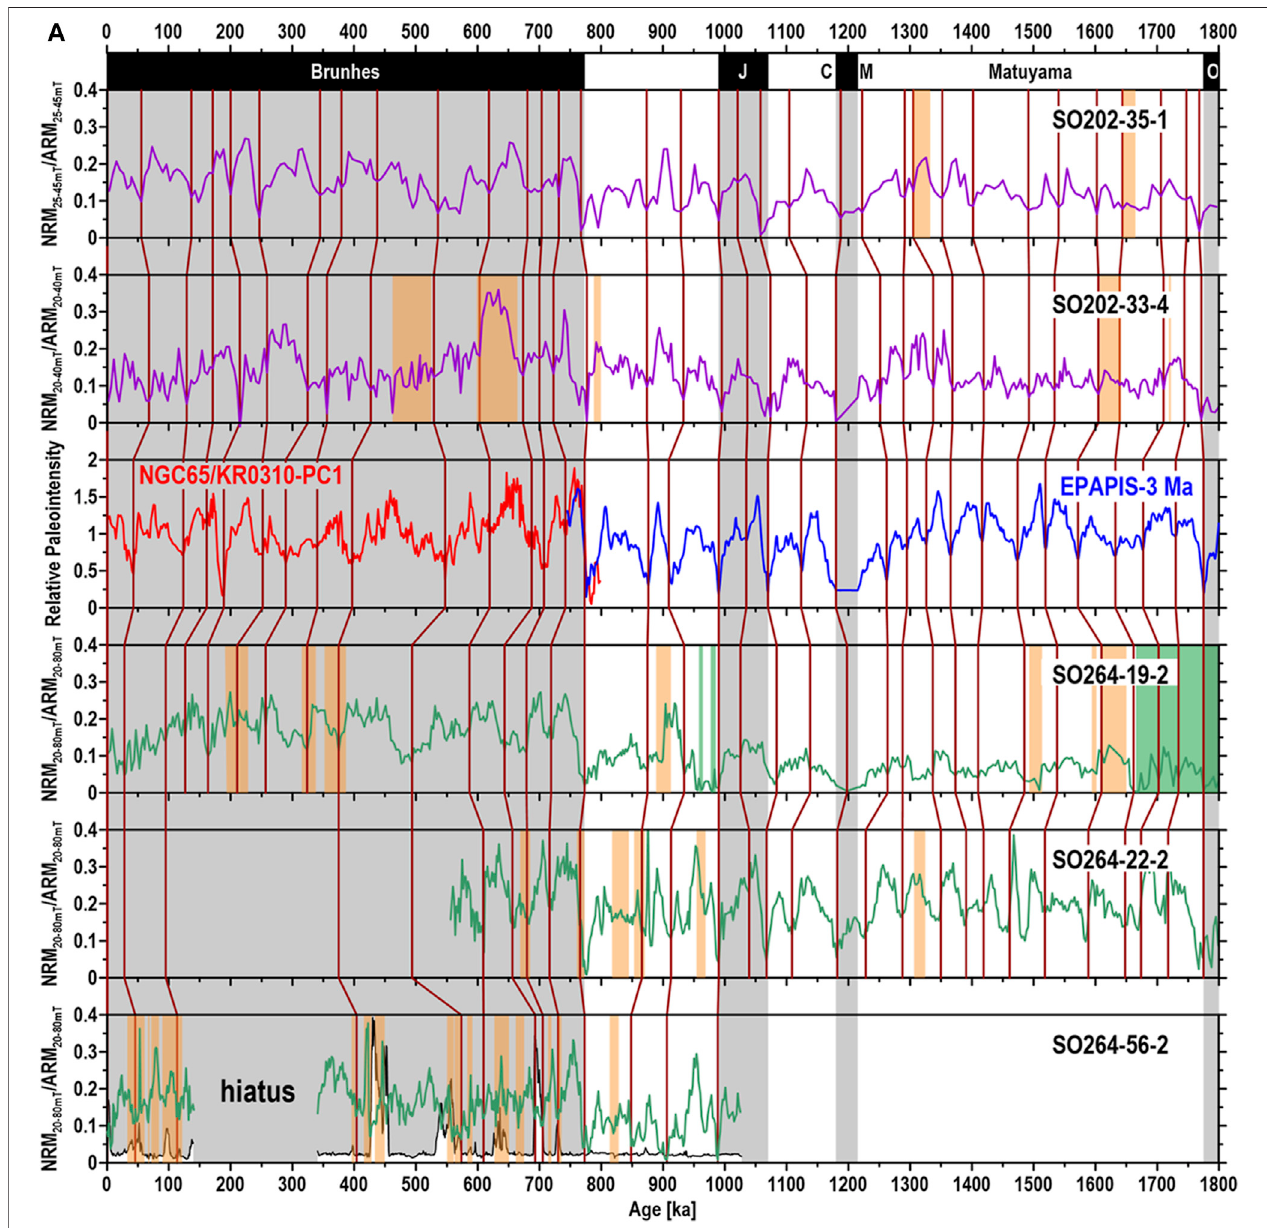
FIGURE 8 | RPI records of two SO202 cores (purple) and three SO264 (green) cores plotted against reversal-based age for the period 0 – 1,800 ka. Also shown is the RPI target record NGC65/KR0310-PC1 (red curve, Hess Rise, 0 – 780 ka, Yamazaki and Kanamatsu, 2007) and EPAPIS-3Ma stack (blue curve, East Paci fi c, 773 – 3,000 ka,YamazakiandOda,2005)adjustedtoGPTS2020(Ogg,2020).TielinesbetweenourRPIrecordsandthetargetRPIrecordsareshowninbrown.Orange and green bands mark volcaniclastic and diagenetic layers, respectively. Black/gray (white) bars at the top of the panel indicate normal (reverse) polarity zones. White peaks with black outline in SO264-56-2 are carbonate layers. Magnetostratigraphic abbreviations: J — Jaramillo Subchron, CM — Cobb Mountain Subchron, O — Olduvai Subchron, F — Feni Subchron (1,700 – 3,500 ka).